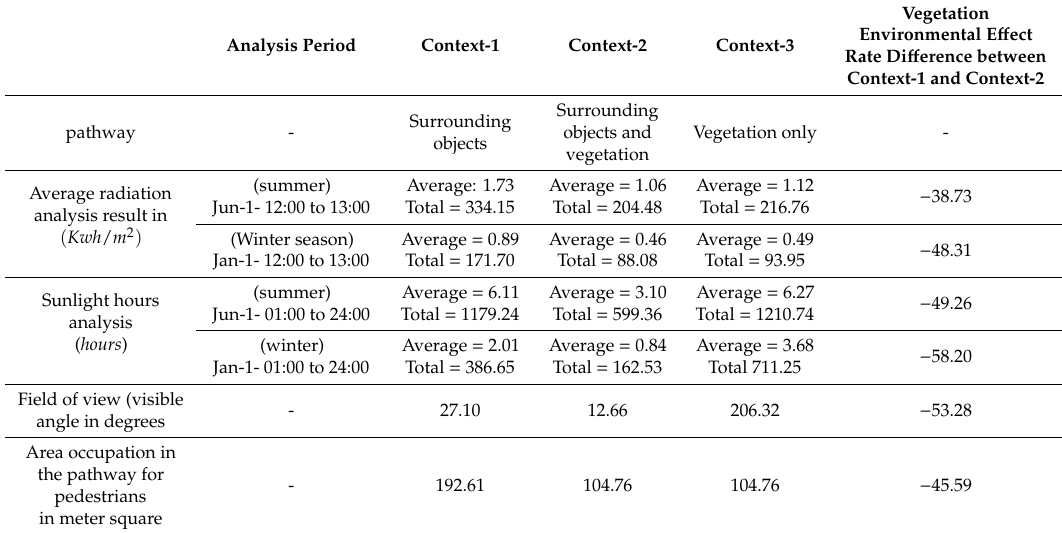
Table 3. Urban Context iteration e ff ects on the targeted pathway environmental and viability